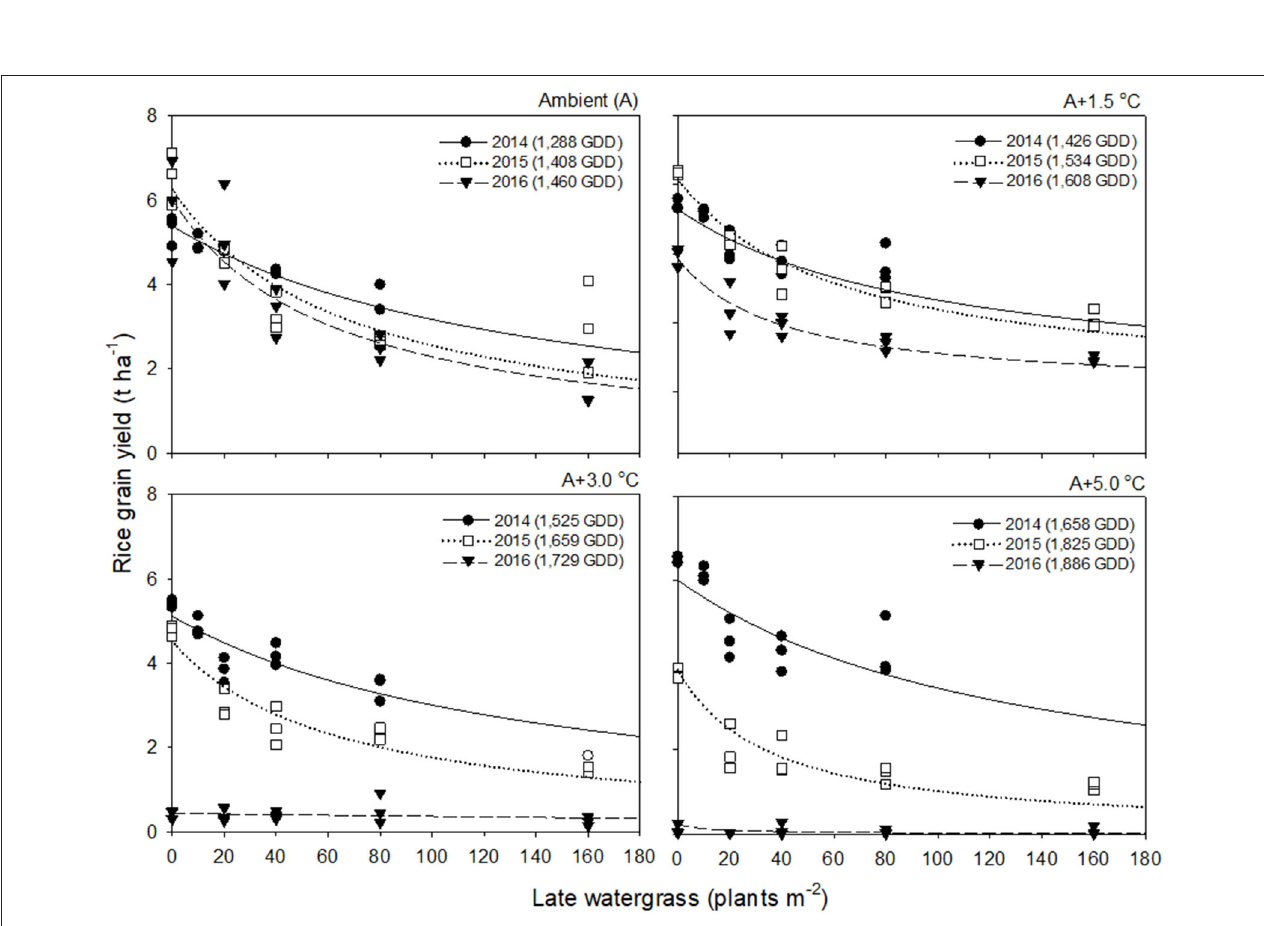
FIGURE 2 | Rice grain yield as a function of the weed density of late watergrass during accumulated growing degree days (GDD; from transplanting to flowering, 89 days) at four sunlit temperature-controlled phytotrons adjusted to ambient (A), A + 1.5 ◦ C, A + 3.0 ◦ C, and A + 5.0 ◦ C in 2014 ( • ), 2015 ( (cid:3) ), and 2016 ( H ). The lines are fitted values calculated, using the rectangular hyperbolic model (equation 3) and parameter estimates ( Table 2 ).